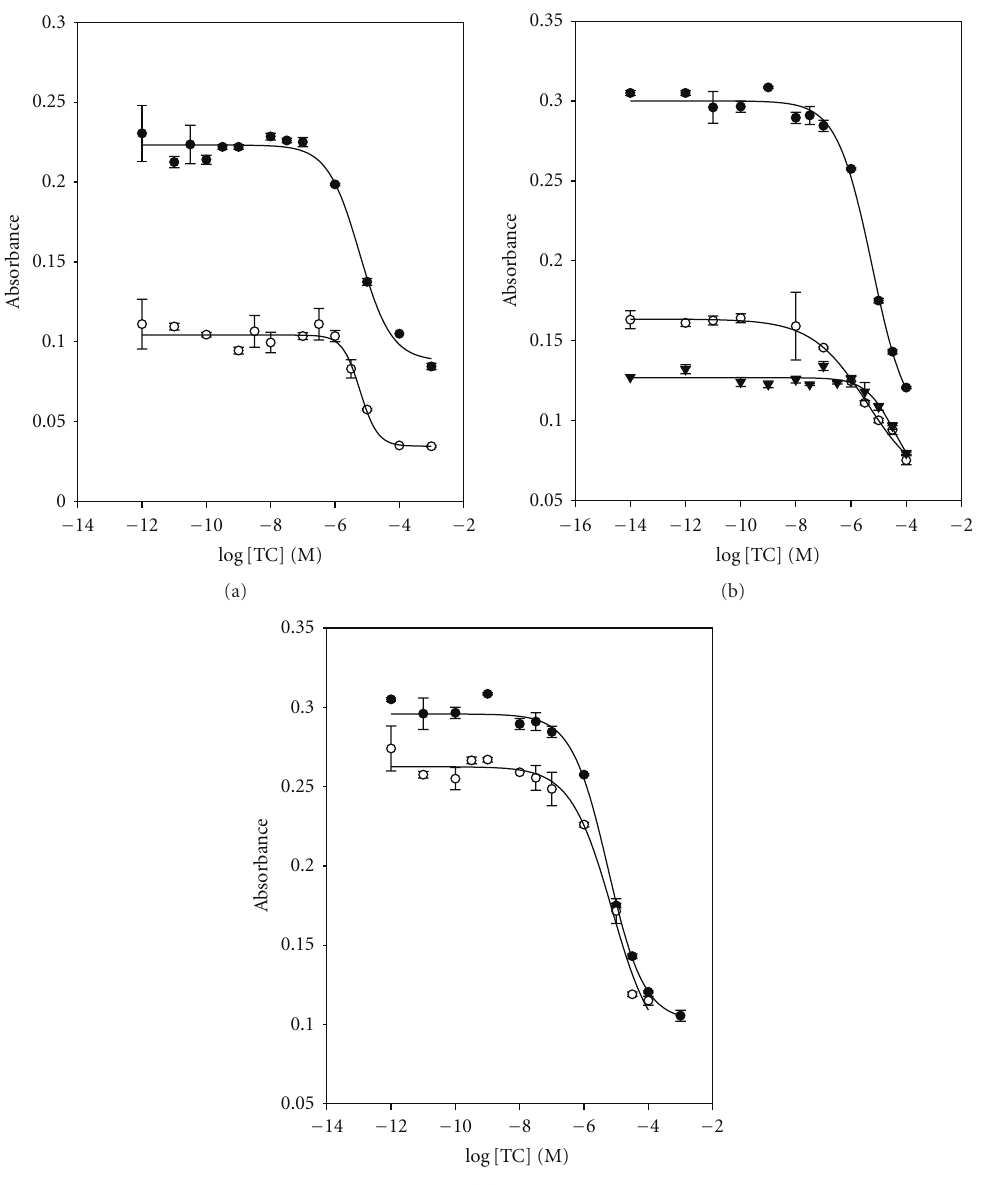
Figure 6: Optimization of assay conditions with RNA aptamer. (a) Influence of the addition of Na + ion on assay bu ff er; ( • ) 10mM phosphate bu ff er and ( ◦ ) PBS bu ff er (150 mM NaCl). (b) E ff ect of the addition of Mg 2+ ion on assay bu ff er. The concentration of MgCl 2 was ( • ) no addition, ( ◦ ) 2.5 mM, and ( (cid:3) ) 5mM. (c) Optimization of temperature on the ELAA performance: ( • ) room temperature and ( ◦ ) 4 ◦